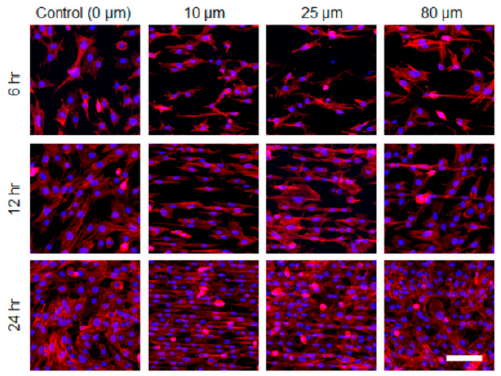
Figure 6. Effect of laser-ablated groove patterns on the adhesion and shape transition of C2C12 myoblasts. Scale bar indicates 100 µ m. Reproduced with permission from [38], [ACS Applied Materials & Interfaces]; published by [ACS Publications], [2016].